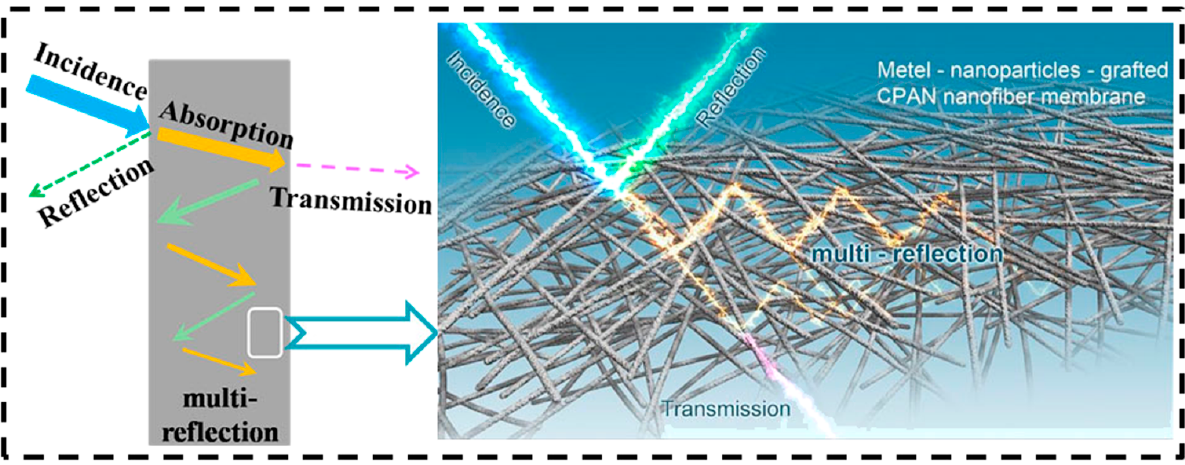
Figure 4. Schematic of the EMI shielding mechanism in the electroless plated PAN membranes. From [62], originally published under a CC-BY license.